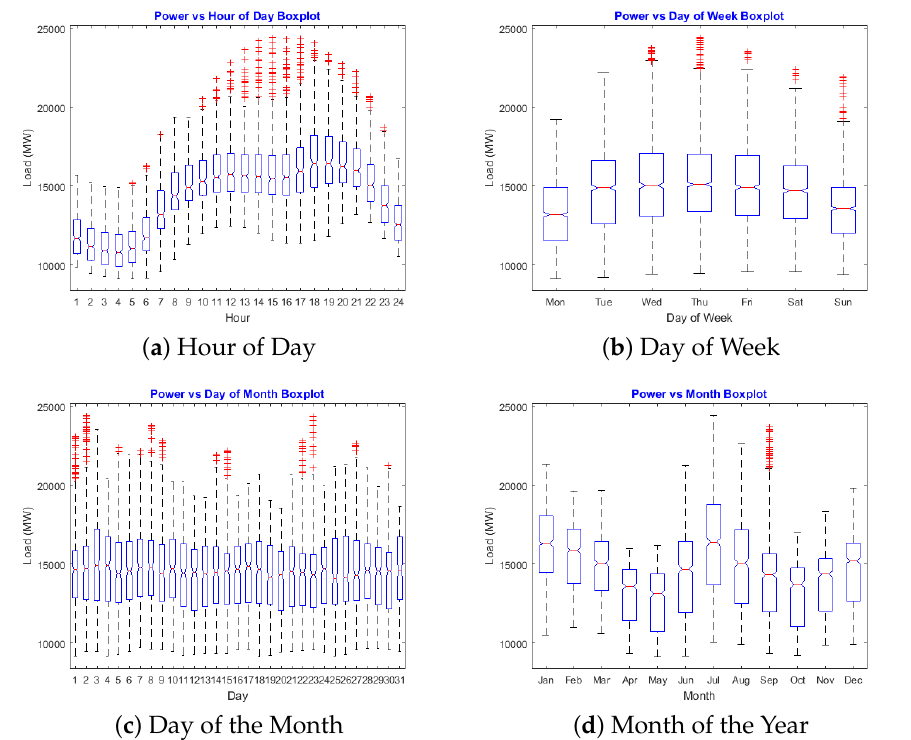
Figure 4. Statistical characteristics of electrical load data, ( a ) Hour of Day; ( b ) Day of Week; ( c ) Day of Month; ( d ) Month of Year.